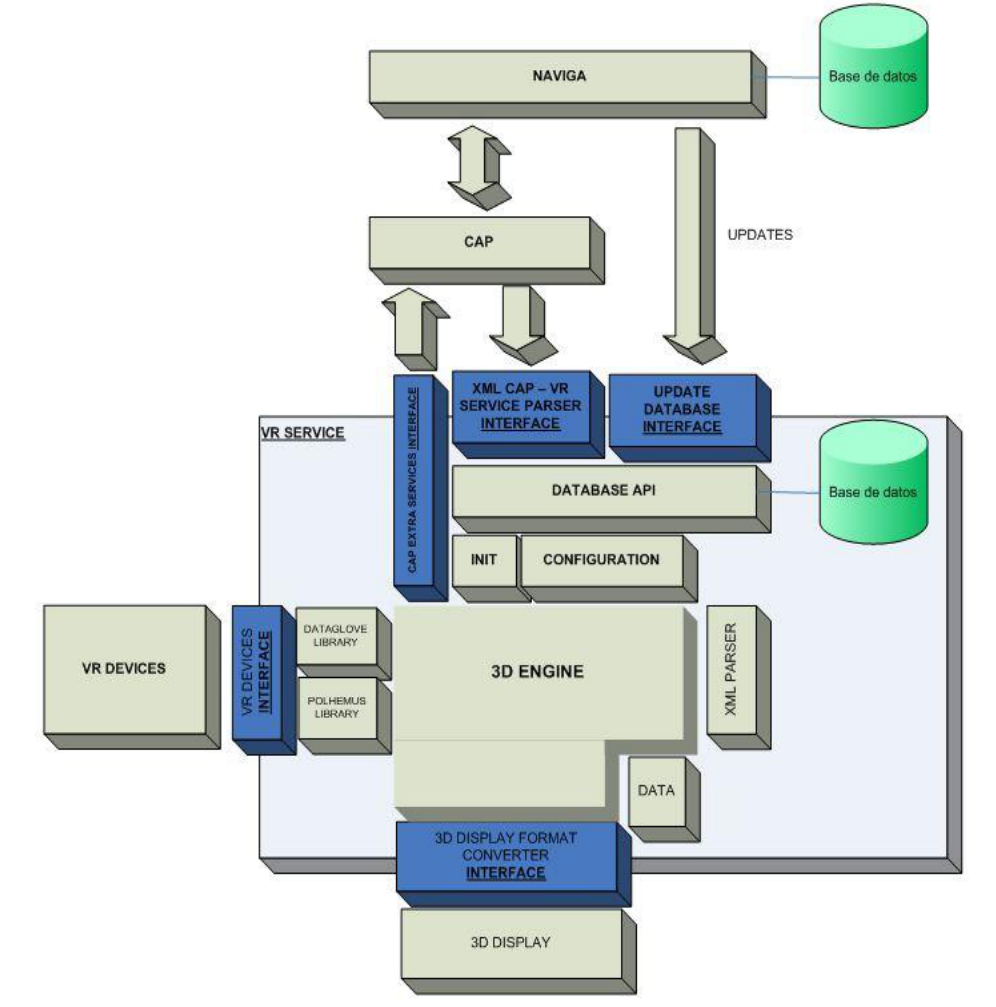
Figure 5. Naviga—VR-Hand-Rehabilitation Service. Blue blocks represent the interfaces involved in this